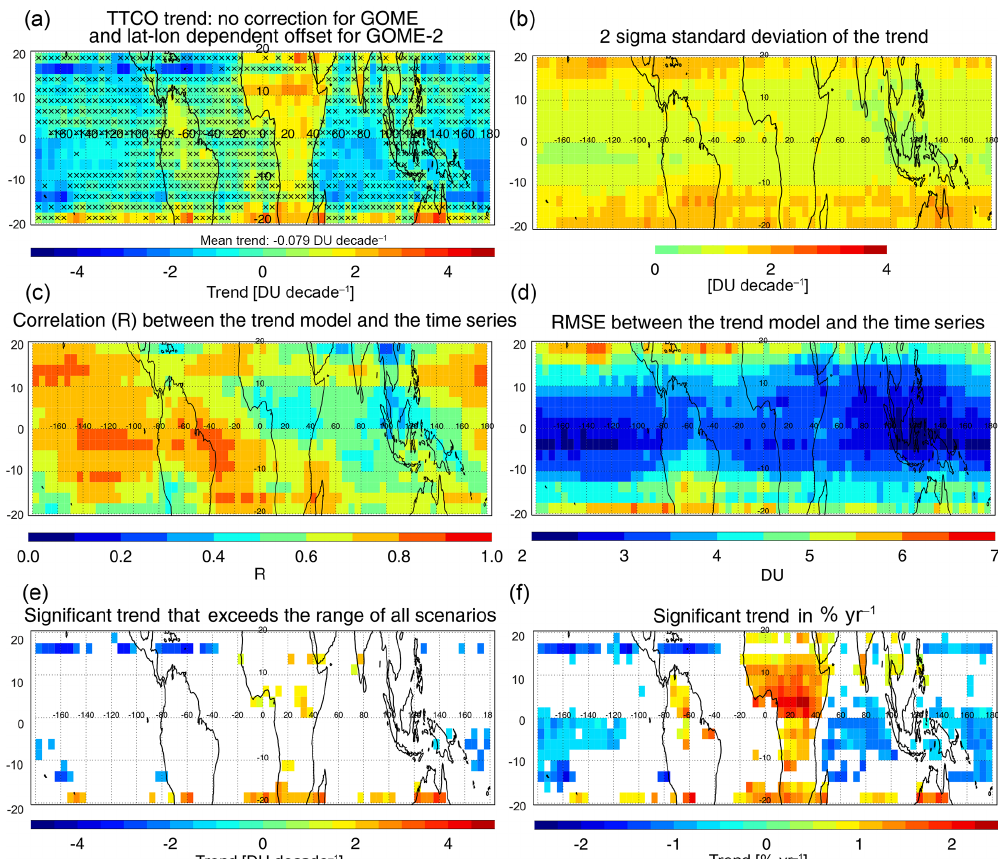
Figure 3. (a) Tropical tropospheric ozone trends using a linear multivariate first order auto-regression model for the selected harmonised scenario 1 inDUdecade − 1 . Grid boxes marked with “ × ” are statistically non-significant at the 95% confidence level ( b > 2 σ β ). (b) 2 σ standard deviation of the trend. (c) The correlation coefficient, R , between the multi-linear trend model fit and the original time series. (d) The RMS between the trend model and the time series. (e) The statistically significant trend that exceeds the maximum absolute difference of the trends calculated for all six scenarios. (f) The significant tropical tropospheric ozone trend in %yr − 1 .